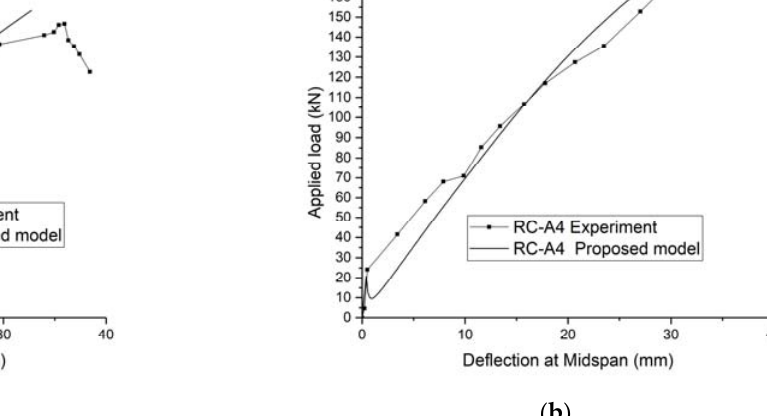
Figure 18. Comparison of present model with load–deflection tests according to ( a ): [33] and ( b ): [34].